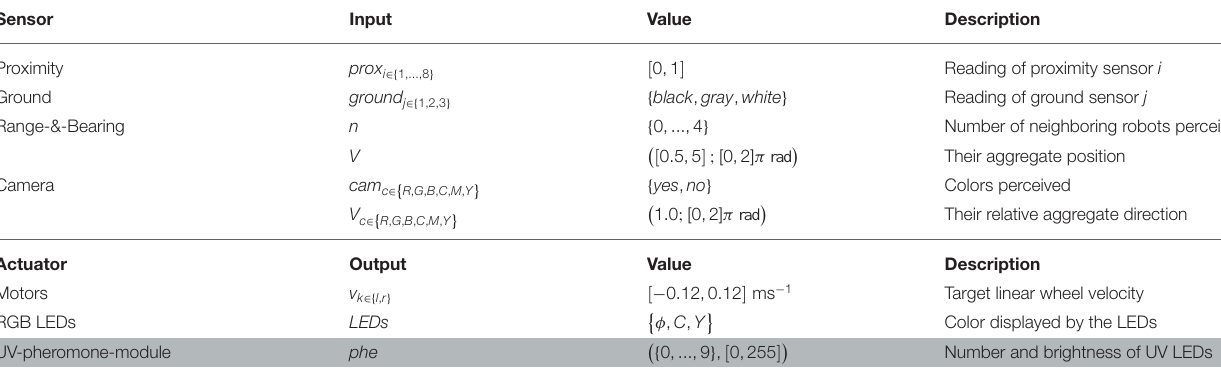
TABLE 1 | Reference Model RM4.0.